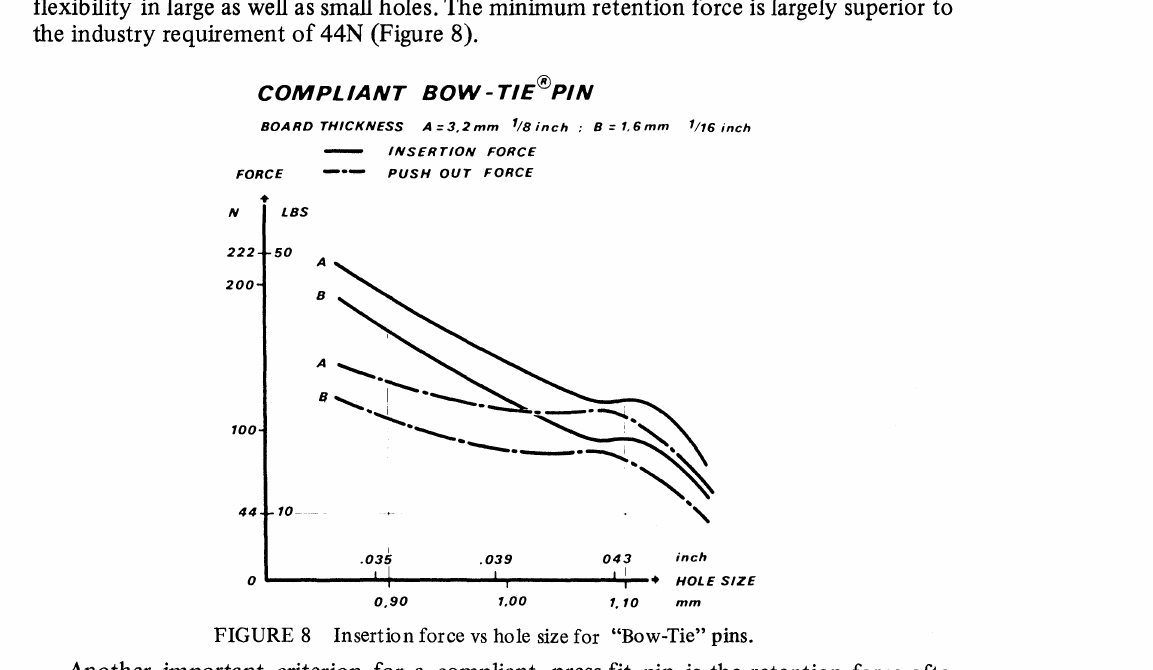
FIGURE 8 Insertion force vs hole size for "Bow-Tie" pins.